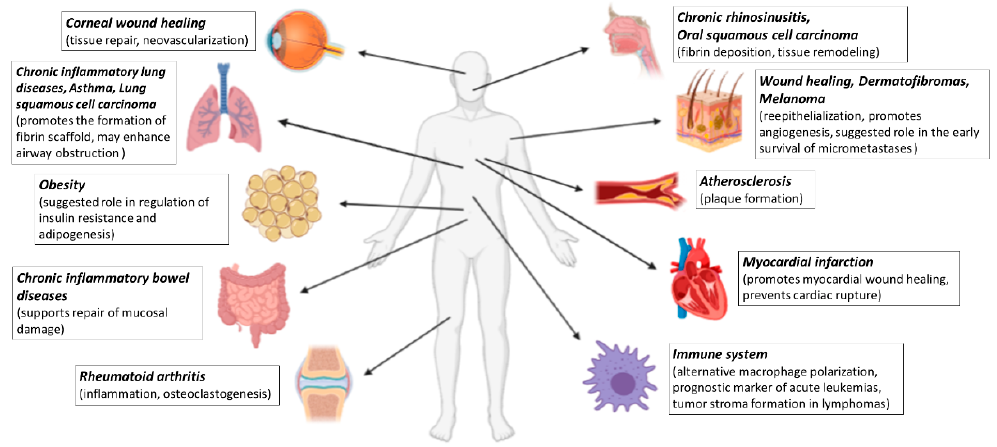
Figure 1. Summary overview of diseases discussed in this review in which FXIII-A may play a role. Created with BioRender.com.